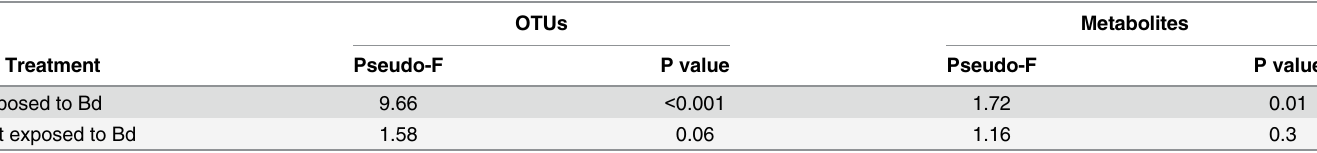
Table 1. Summary of PERMANOVA results comparing microbial community structure (beta diversity of OTUs, UniFrac distance matrices) and function (Metabolite profiles, Sorensen dissimilarity matrices) across microbiota manipulations of frogs exposed and not exposed to Bd. Visuali- zations of these comparisons can be seen in Fig